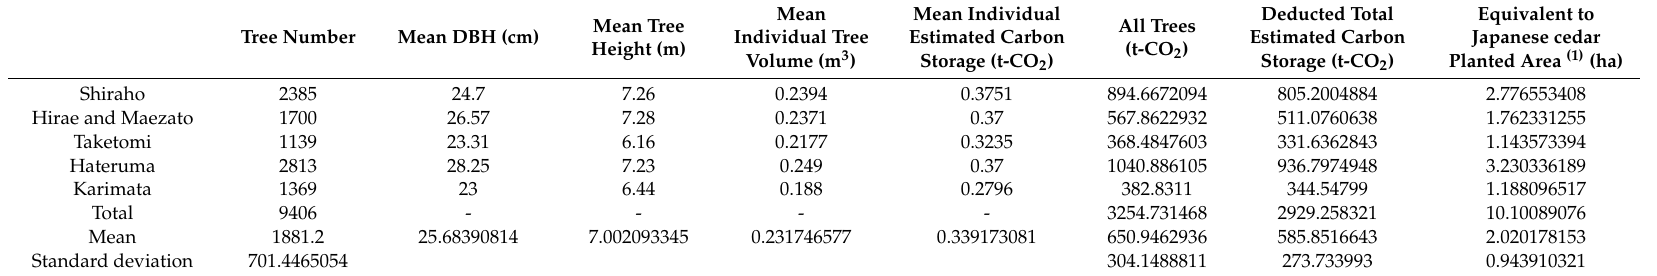
Table 4. Total carbon storage data in five survey sites on Yaeyama Islands (Ishigaki Islands and Miyako